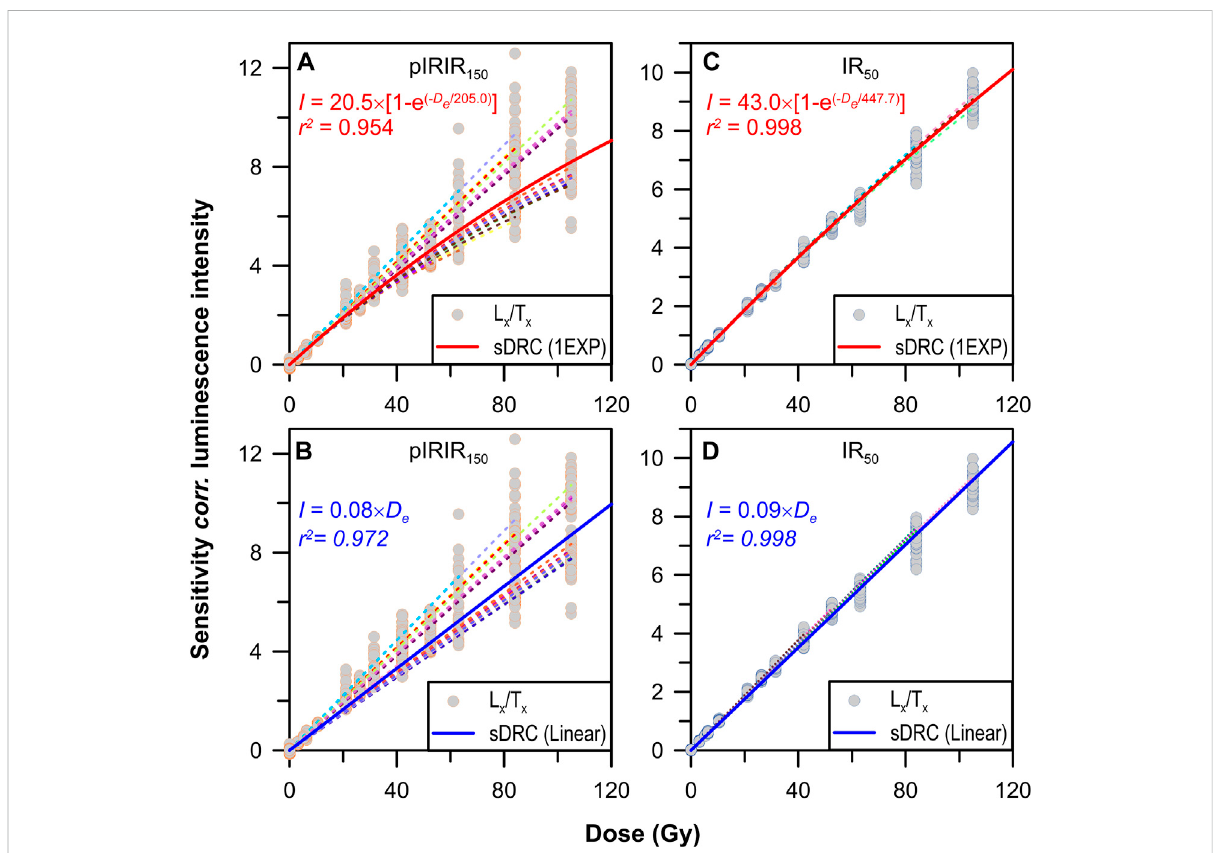
FIGURE 4 Construction and comparison sDRC using data from all the samples following Li B et al. (2015a). (A,B) The pIRIR 150 sDRCs using data of all the samples fi tted by the one saturating exponential (1EXP) and linear functions, respectively (solid line). (C,D) The IR 50 sDRCs using data of all the samples fi